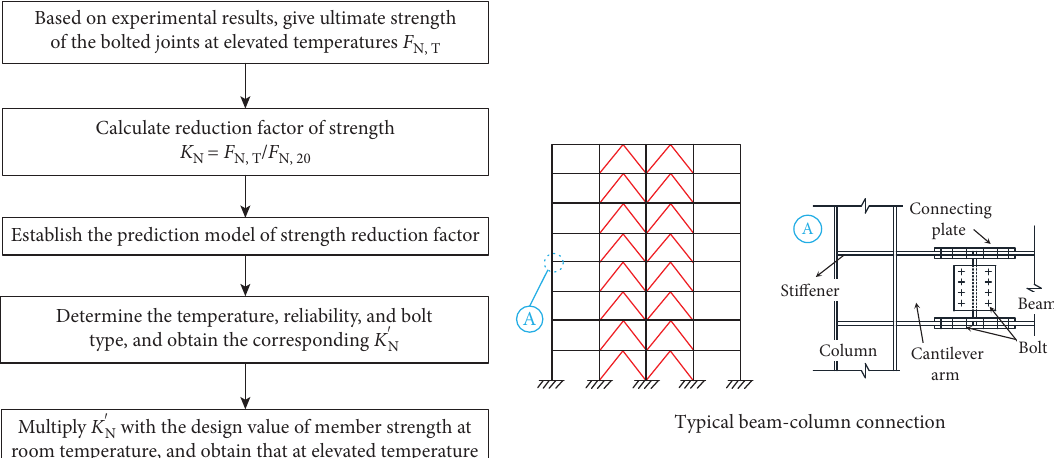
Figure 11: An illustrative design example.